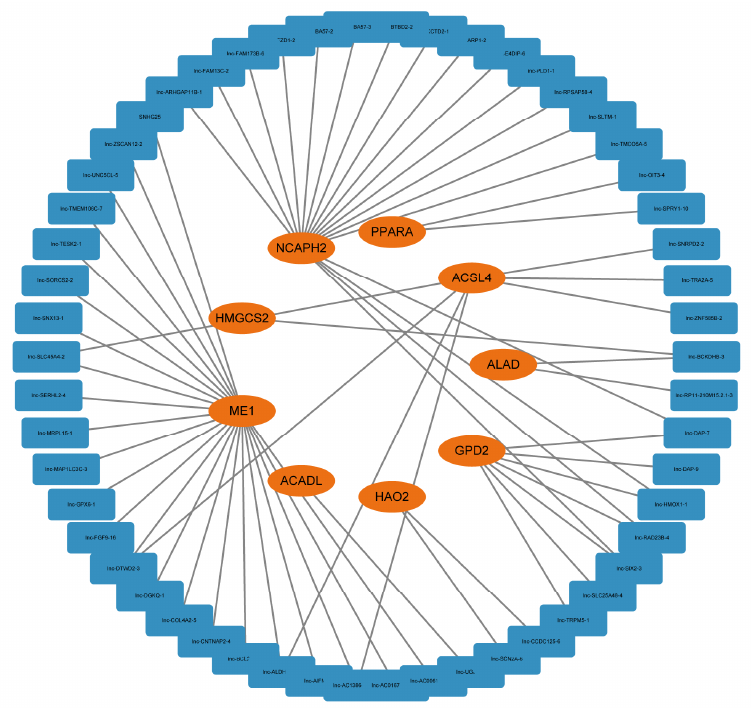
Biomolecules 2023 , 13 , x FOR PEER REVIEW Figure 8. A FAM-related lncRNA-mRNA regulatory network consisting of 9 mRNAs and 54 lncRNAs.